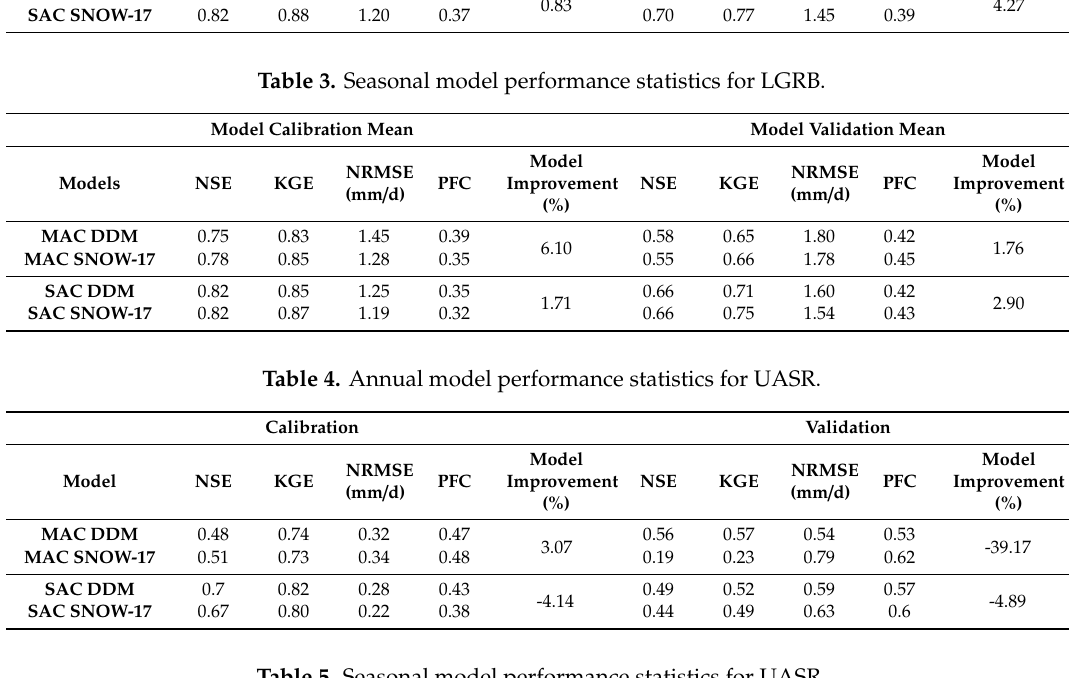
Table 5. Seasonal model performance statistics for UASR.